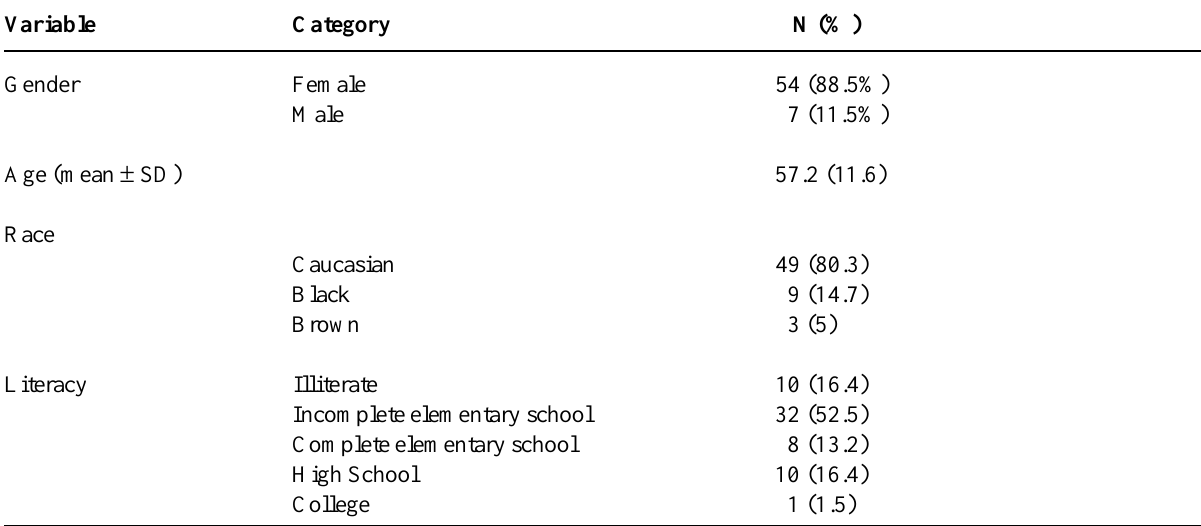
Table 1 – Background data on sample population assessed by ICIQ-SF.